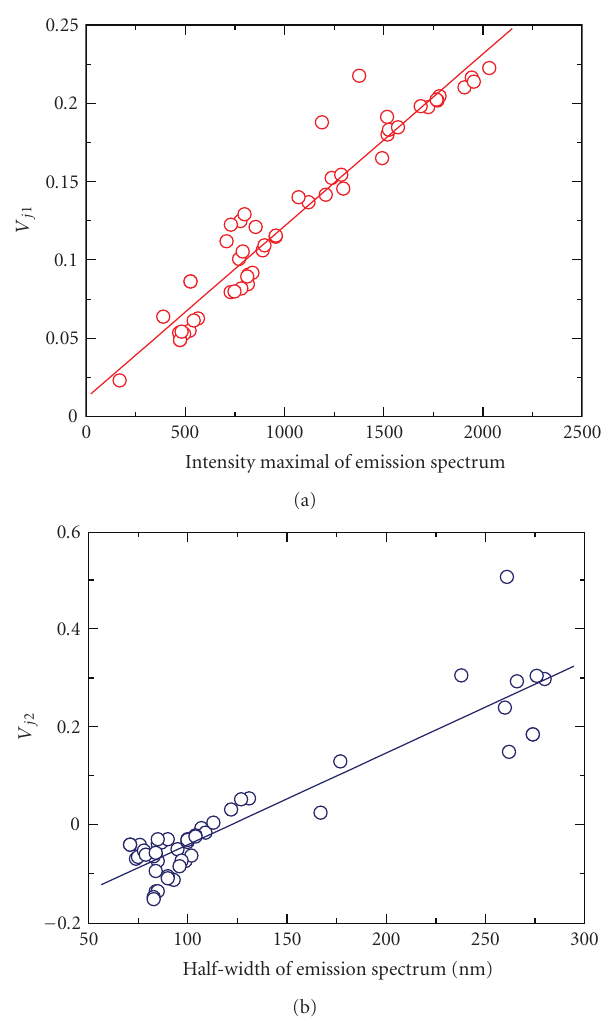
Figure 5: Correlations between eigenvector elements and spectral characteristics. (a) Elements of the first eigenvector of the covari- ance matrix V j 1 are plotted against the peak height of the respective spectrum. The slope and intercept of the fitted straight line are 1 . 1 · 10 − 4 ± 4 . 5 · 10 − 6 and 0 . 012 ± 0 . 005. The correlation coe ffi cient is 0.96. (b) Elements of the second eigenvector of the correlation matrix V j 2 are plotted against the half-width of the respective spectrum. The slope and intercept of the fitted straight line are 0 . 0019 ± 0 . 00012 and − 0 . 229 ± 0 . 017. The correlation coe ffi cient is 0.91.